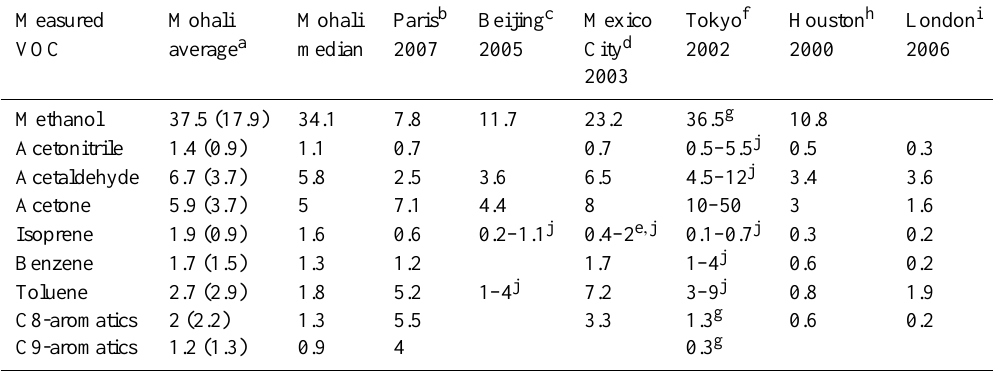
Table 3. Average, median and standard deviation of VOCs measured at IISER Mohali in May 2012 and comparison with average levels reported in summertime from other cities of the world. All values are reported in nmolmol − 1 . Measured Mohali Mohali Paris b Beijing c Mexico Tokyo f Houston h London i VOC average a median 2007 City